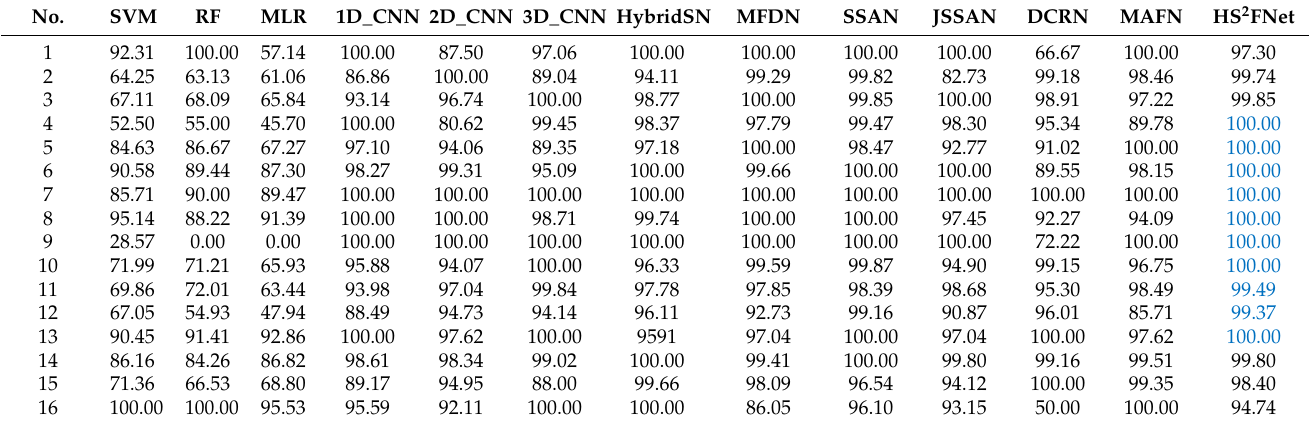
Table 7. Quantitative comparisons of the state-of-the-art models and our network on IP